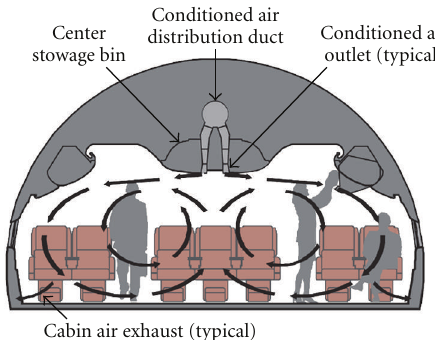
Figure 2: A typical mixing ventilation system